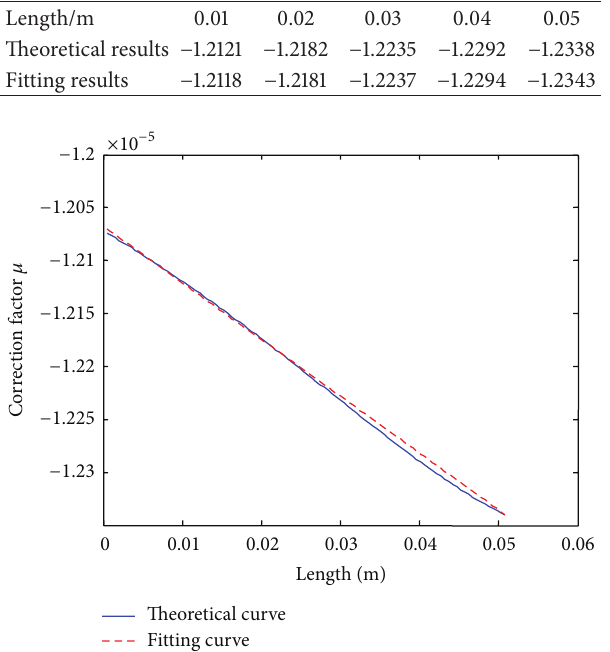
Figure 3: Correction factor with cantilevered length for theoretical calculation and fitting results.